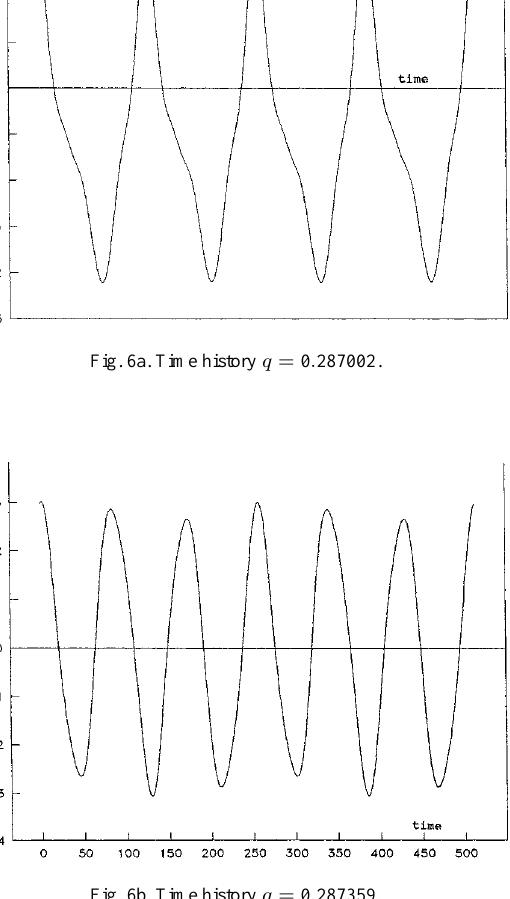
Fig. 6b. Time history q = 0 : 287359.